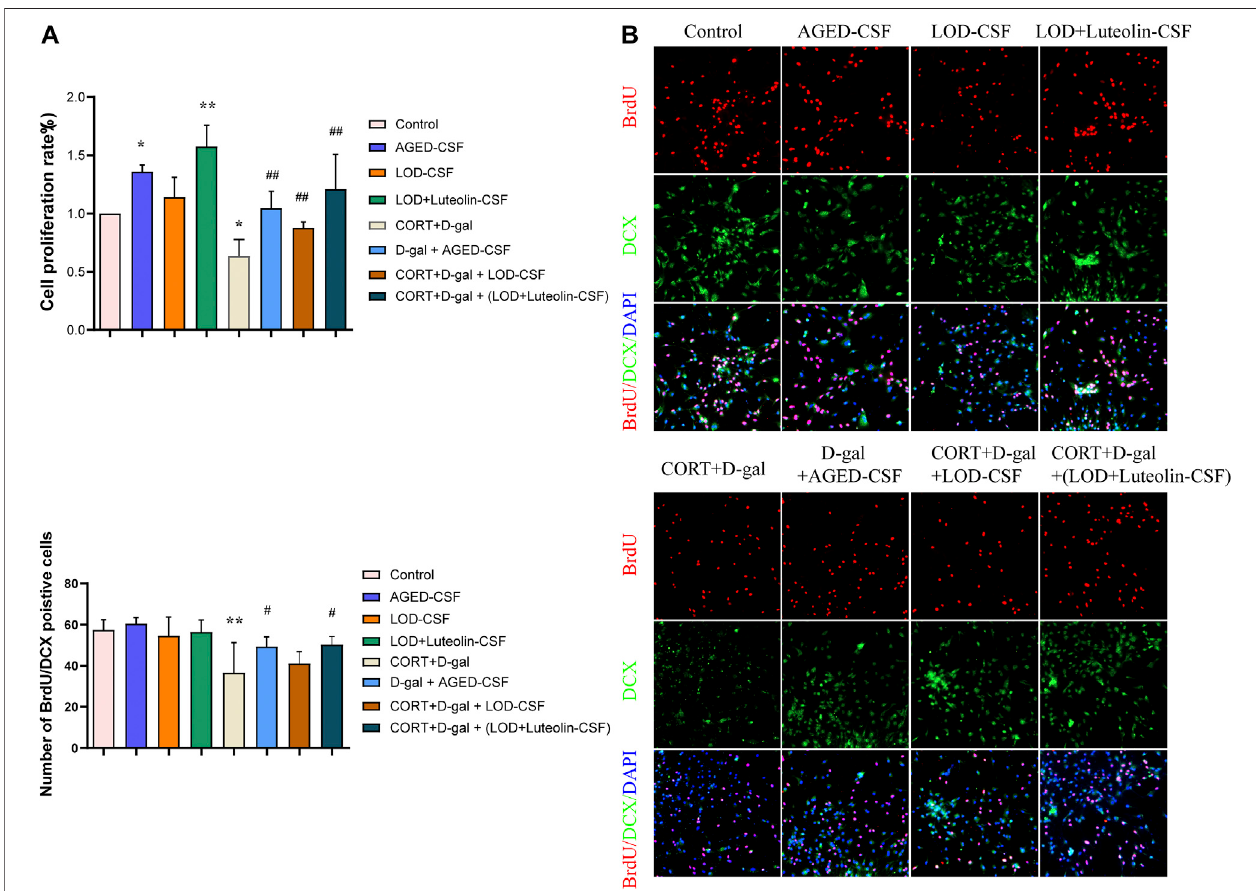
FIGURE 5 | Effects of Luteolin CSF on the proliferation and differentiation of CORT + D-gal – induced primary hippocampus NSCs. (A) NSC viability was measured using a CCK-8 assay ( n = 3). (B) DCX/BrdU double-positive NSCs were observed by immuno fl uorescence ( n = 4). Data in each group were consistent with a normal distribution (Shapiro – Wilk test) and exhibited homogeneity ofvariance; one-way analysis of variance was then used for comparisons. Data areexpressed as the mean ± SEM, * p < 0.05, ** p < 0.01, vs. Control; # p < 0.05, ## p < 0.01, vs. CORT + D-gal.